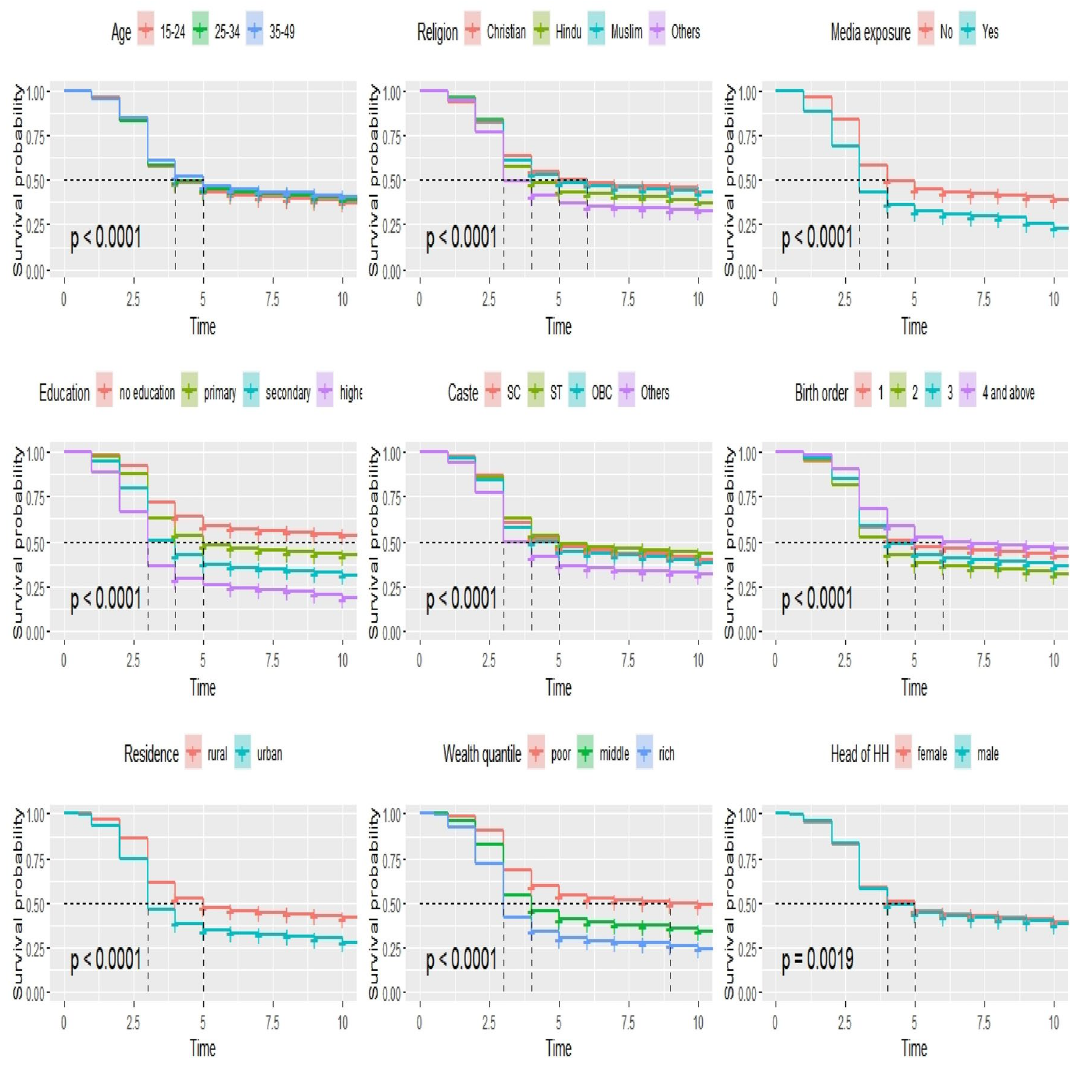
Figure 3. Survival estimate of time to first ANC visit by woman’s characteristics in India. ( Source: NFHS-4, 2015–2016